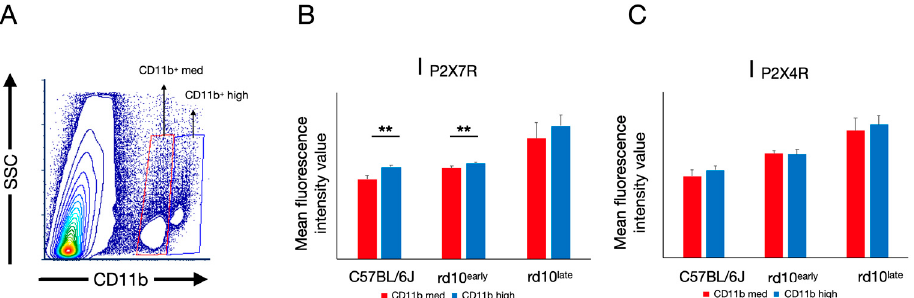
Figure 8. P2X7R and P2X4R expression analysis in CD11b+ cells, assessed by flow cytometry. Whole retinal cells from C57BL/6J, rd10early, and rd10late mice were triple-stained with antibodies against CD11b, P2X7R, and P2X4R. After discarding the cell debris and selecting singlets, CD11b- immunopositive cells were gated and two populations were selected according to medium or high immunoreactivity against the CD11b antibody, as shown in the contour plot (rd10 postnatal day [P]18) ( A ). The dot plot shows the sum of a minimum of 3 independent replicates. The immunoreactivity against P2X7R ( B ) and P2X4R ( C ) was compared in the two CD11b populations of each group of mice. Student’s t -test was performed between the two populations in each condition. Data are presented as mean values ± SD. Student’s t -test, ** p < 0.01. C57BL/6J: P47; rd10early: P18 and rd10late: